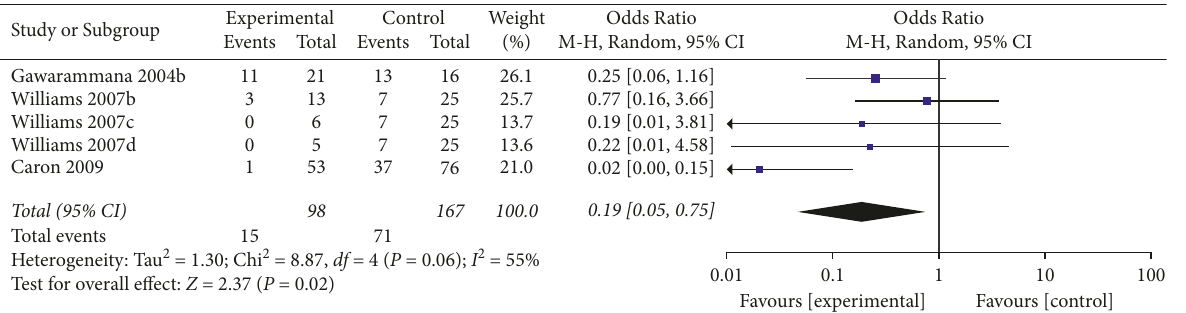
Figure 5: Forest plot of ADRs associated with antivenom use following snakebite between the prehydrocortisone with other drugs groups and the placebo or no premedication groups in five comparisons from three